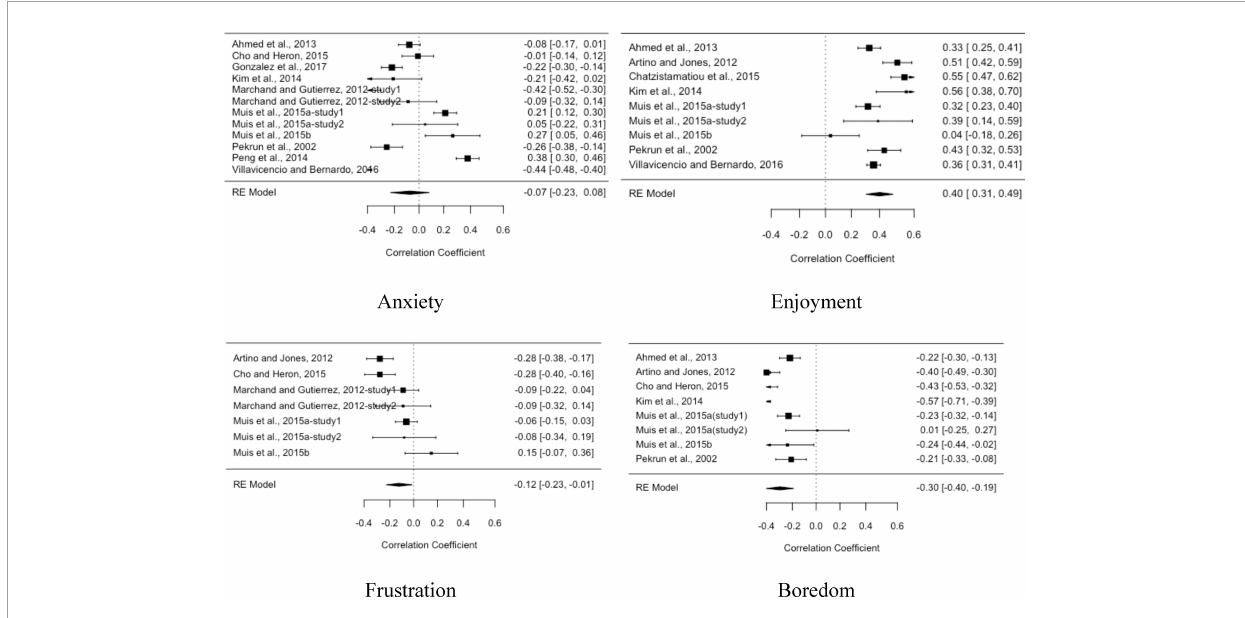
FIGURE1 The forest tree of anxiety, enjoyment, frustration, and